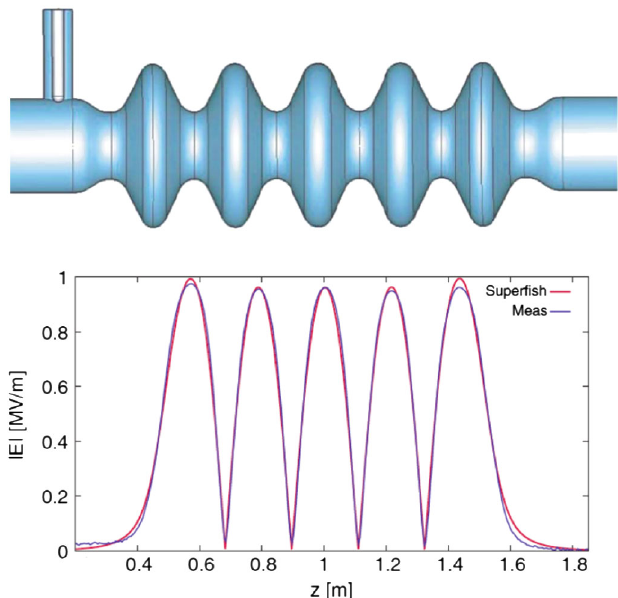
FIG. 2. (Color) Structure of the 703 MHz BNL five-cell cavity (top), and a simulated by SUPERFISH and a measured field envelope of the fundamental mode (bottom)